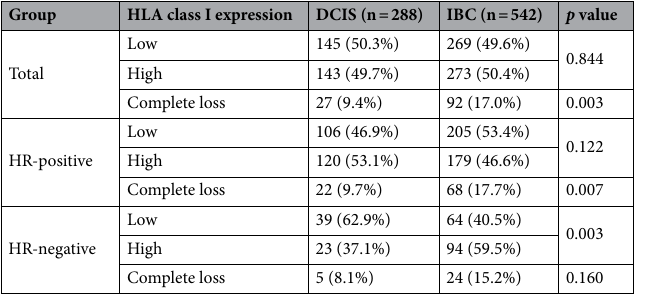
Table 1. Comparison of HLA class I expression in DCIS and IBC. p values are calculated by Chi-square test. DCIS ductal carcinoma in situ, IBC invasive breast carcinoma, HLA human leukocyte